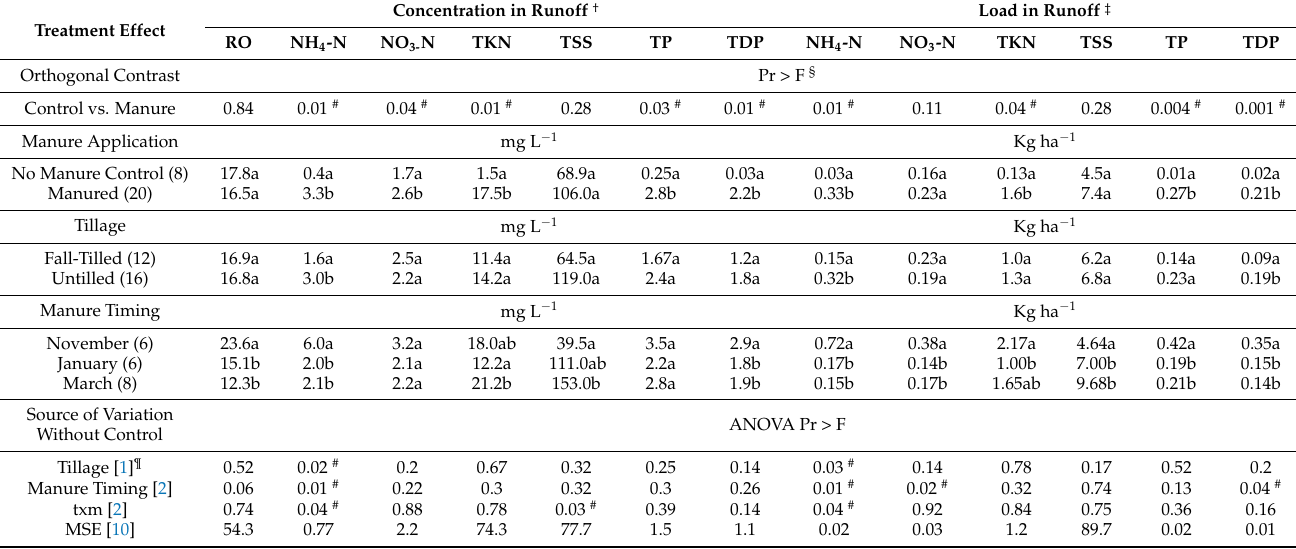
Table 4. Treatment mean comparisons of runoff, nutrient concentrations, and loads in snowmelt, as influenced by tillage and time of manure application,